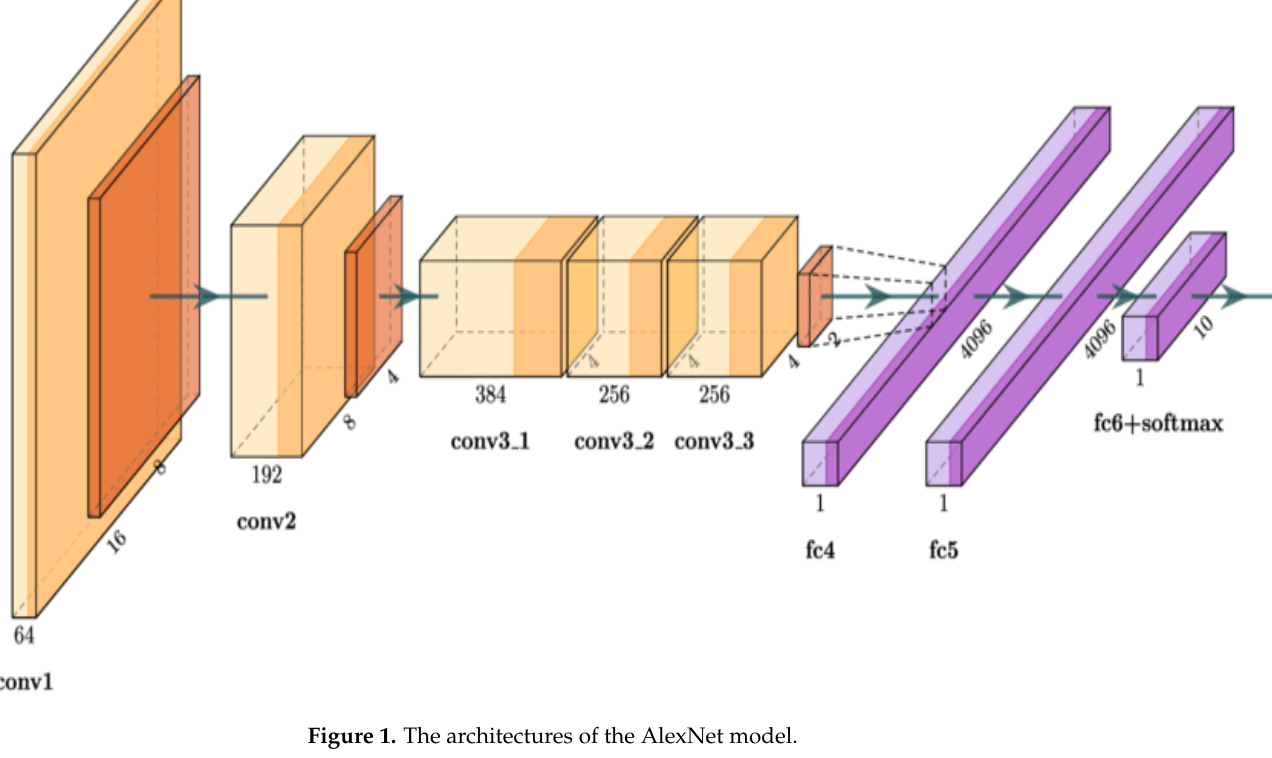
Figure 1. The architectures of the AlexNet model.